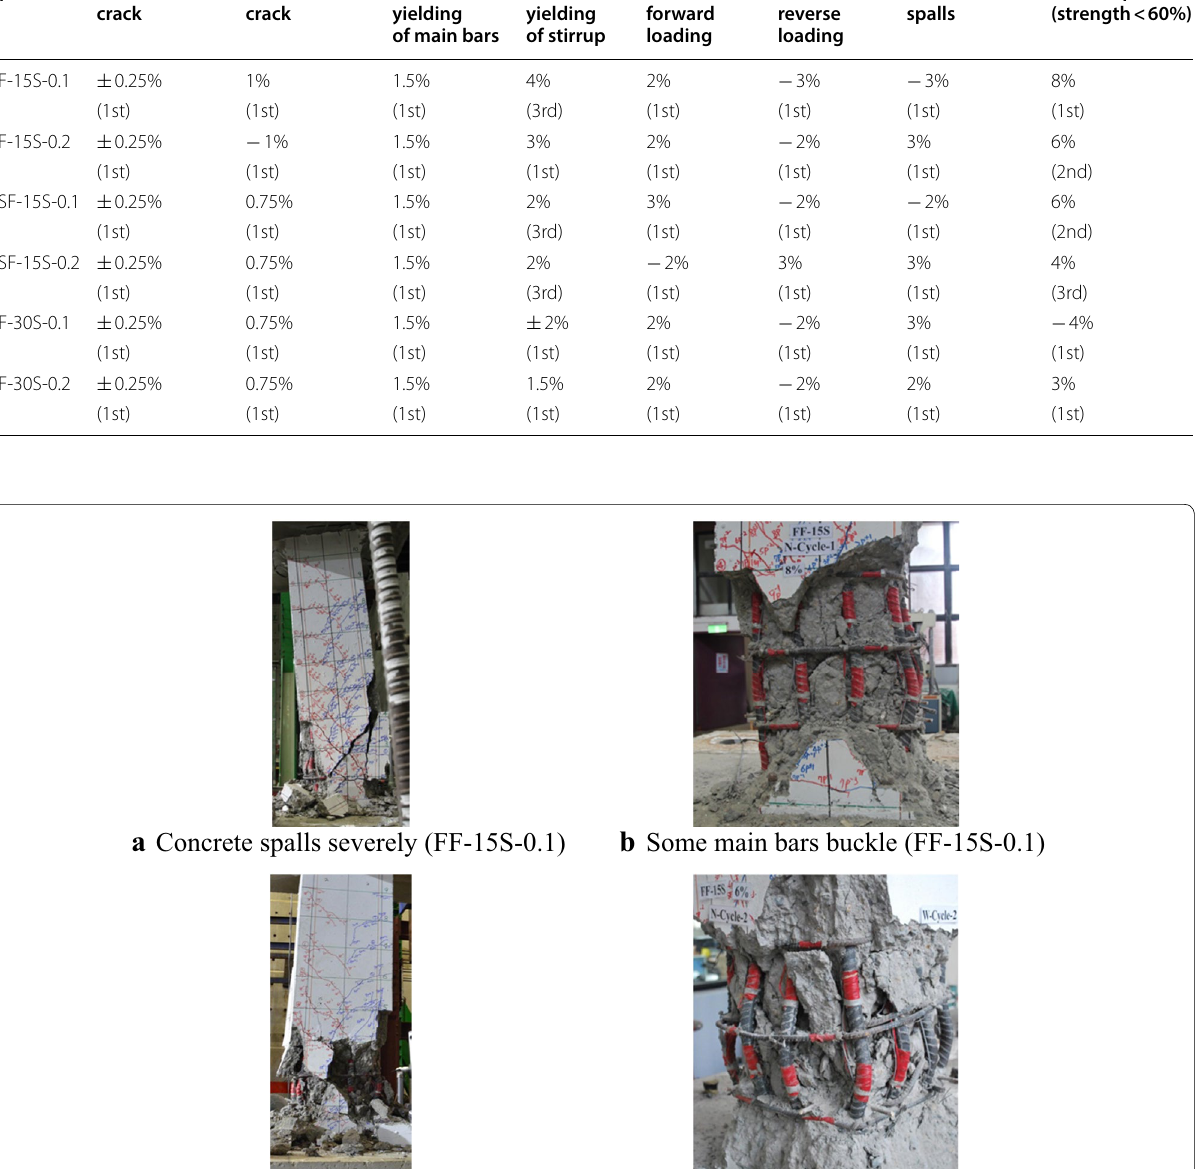
d Some main bars buckle (FF-15S-0.2)